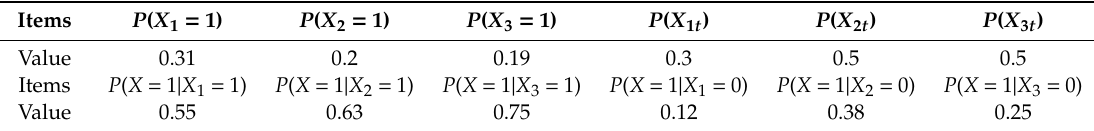
Table 3. Expert score table of node “Overtopping” ( × 10 − 4 ).